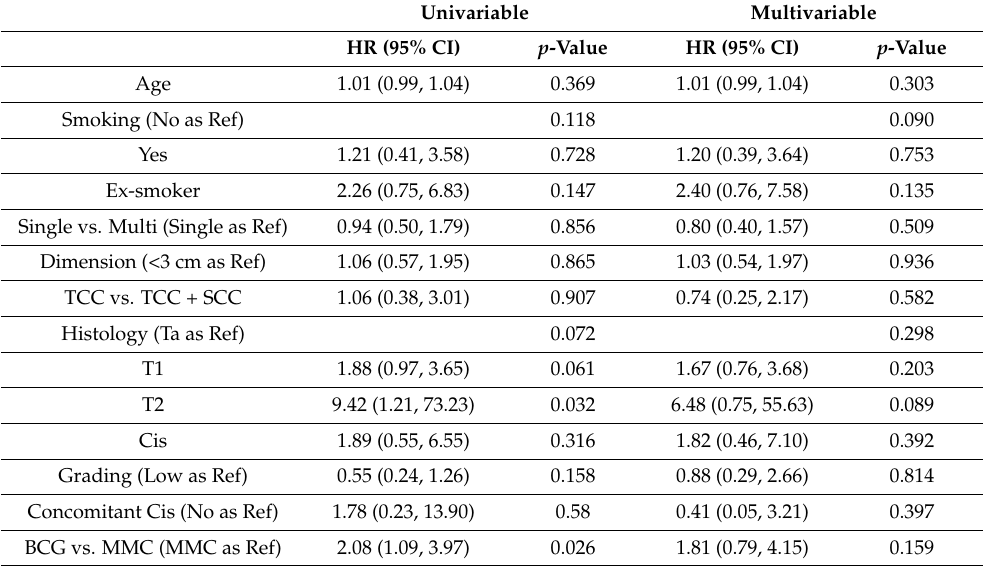
Table 3. Multivariable Cox regression analysis predicting